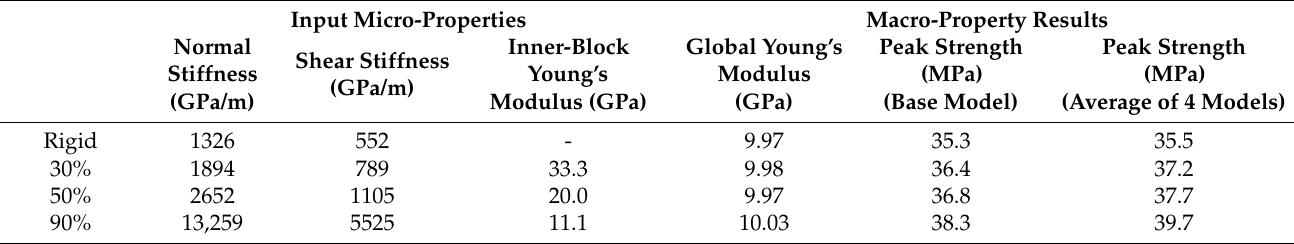
Table 3. Joint stiffness used in 3 cases and results sample for deformability and strength. Input